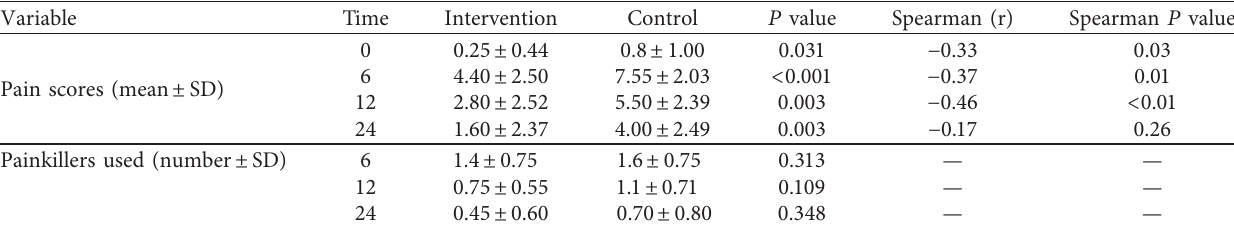
Table 2: The mean pain scores and number of painkillers used in the two groups at different times.